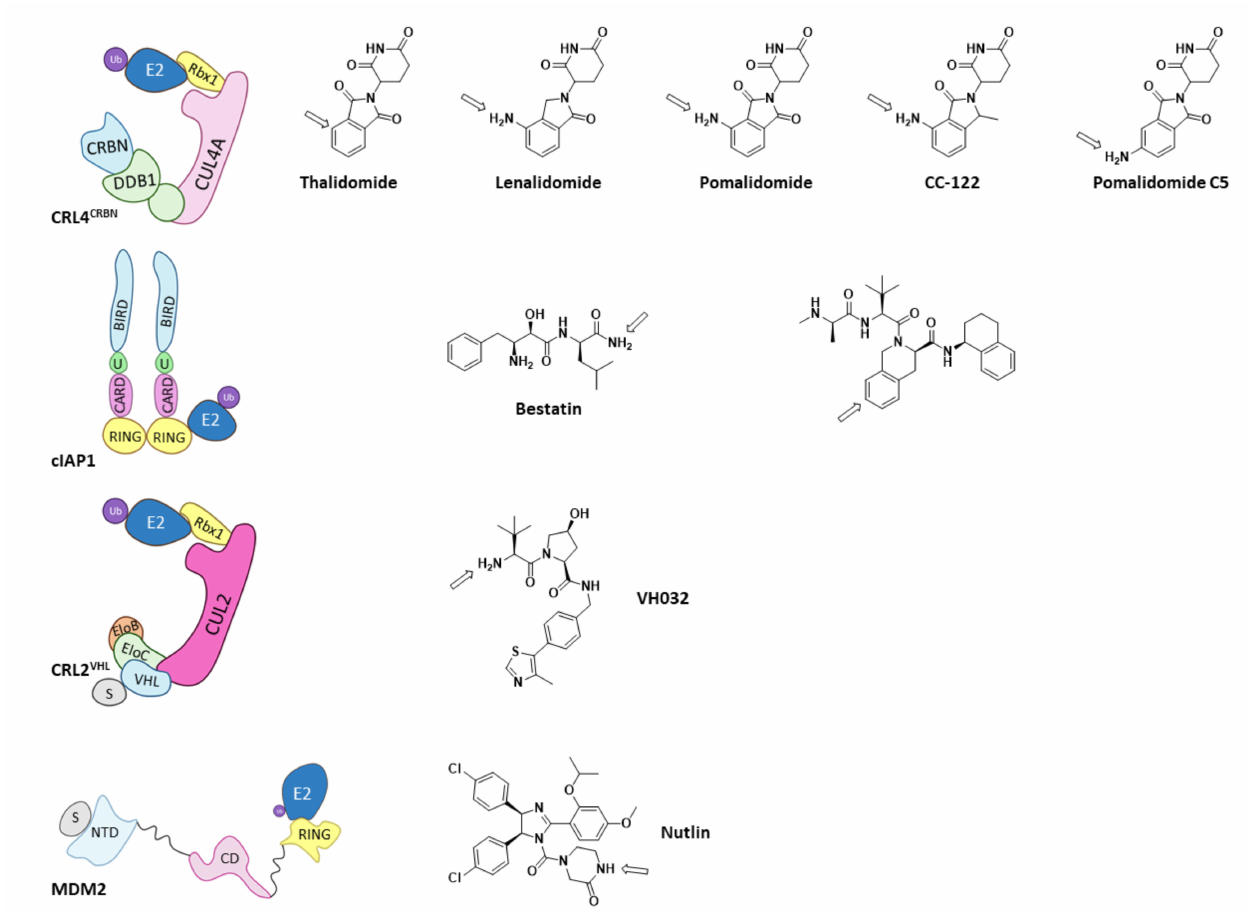
Figure 12. Schematic representation of the assembly of the E3 ligases that have been used for PROTAC design and the 2D representation of the structures of their respective ligands with and arrow marking the position for the functionalization. Adapted from Scheepstra M. et al.